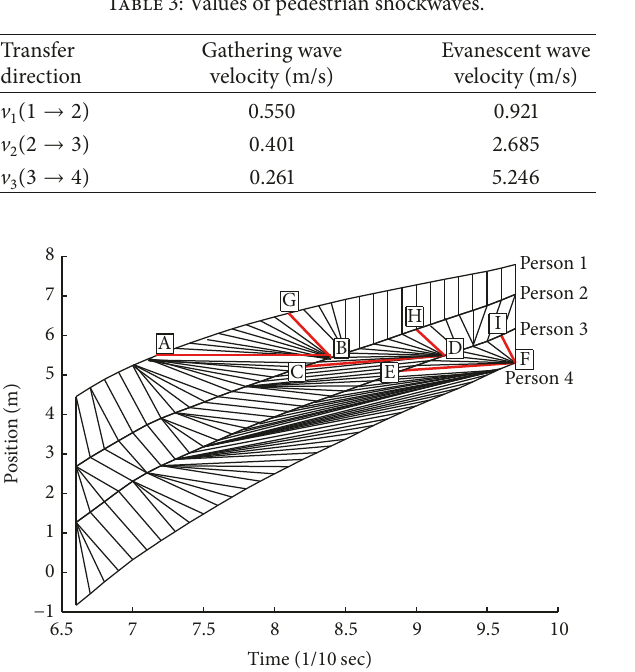
Figure 4: Key points highlight in matching